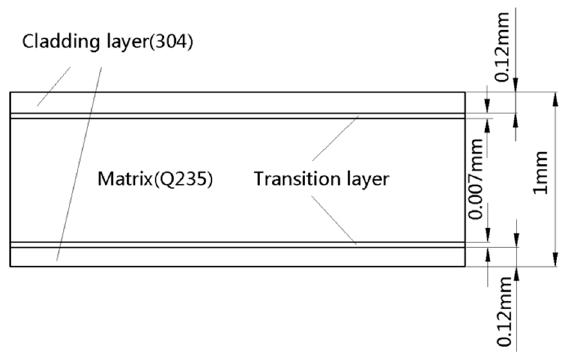
Figure 1. Schematic of the SCLP.